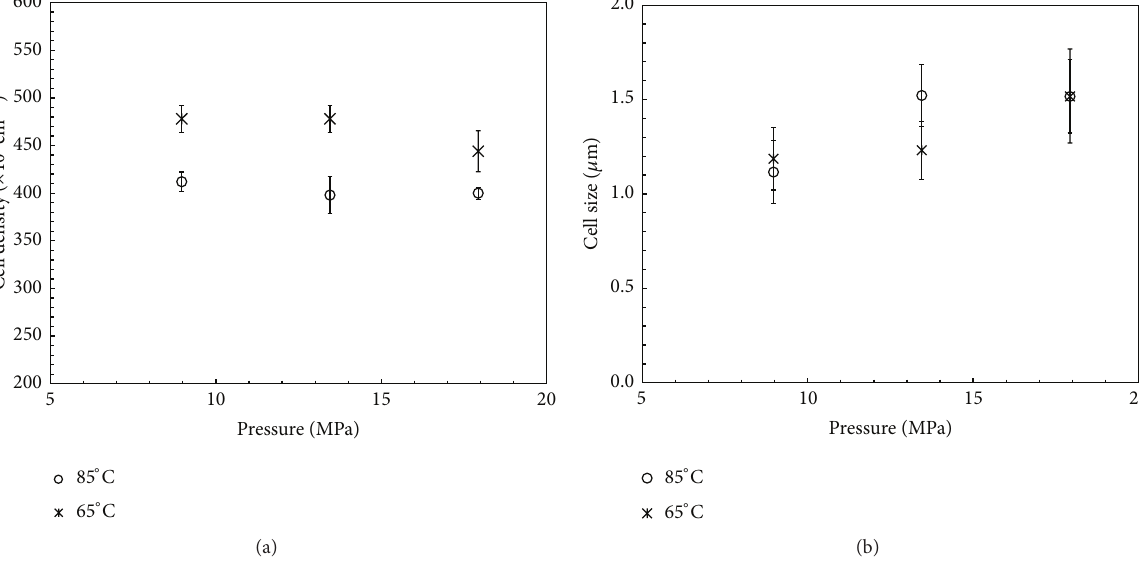
Figure 8: (a) Cell density and (b) cell size of the highly fluorinated, high concentration (FF-High) sample processed at 65 and 85 ∘ C at saturation pressures 8.97, 13.45 and 17.93 MPa. The error bars show the standard error of five